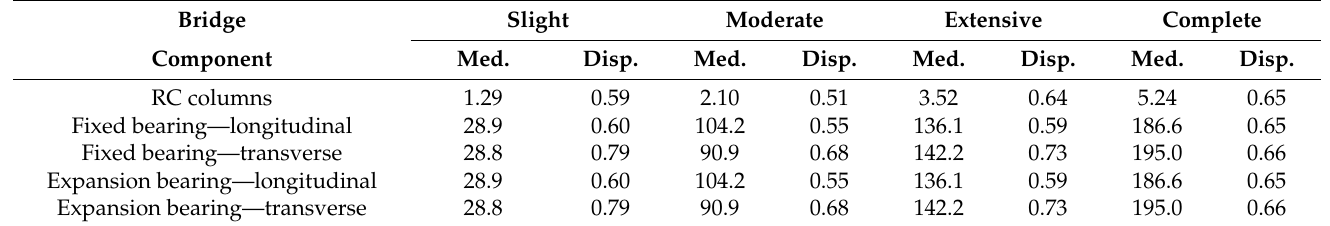
Table 6. Capacity limit state for different bridge components for an MSC concrete girder